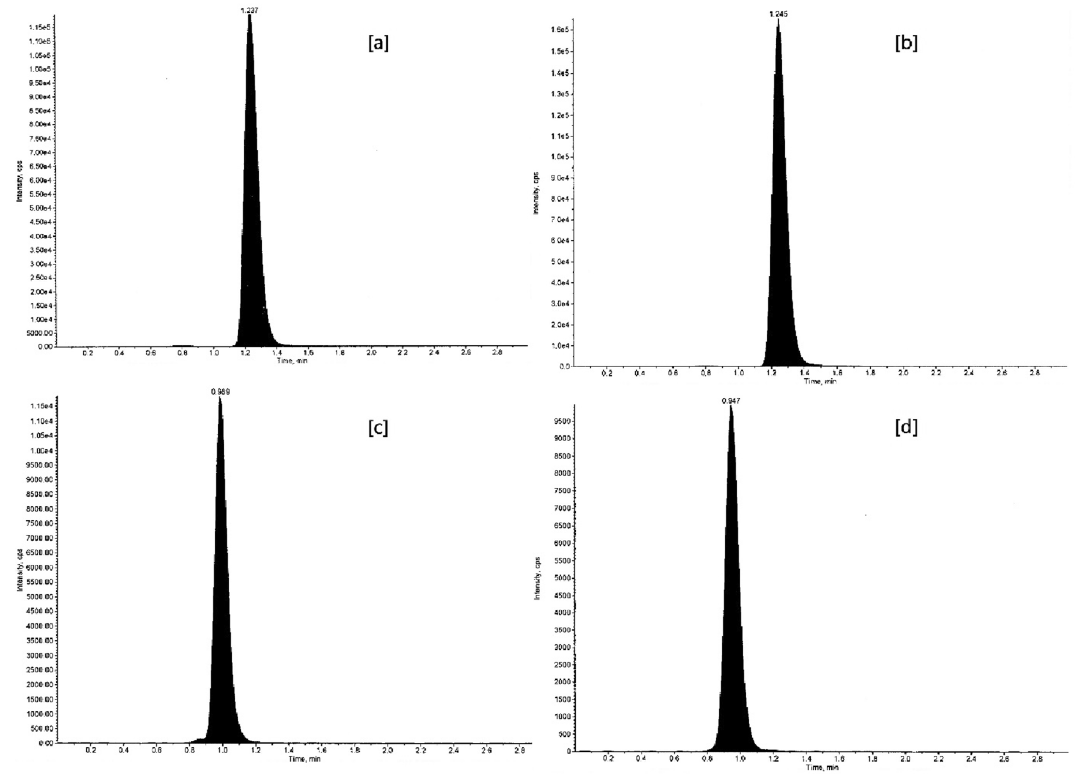
Figure 12. Representative chromatograms of ( a ) venlafaxine C max Test, ( b ) venlafaxine C max Ref, ( c ) O -desmethylvenlafaxine C max Test, and ( d ) O -desmethylvenlafaxine C max